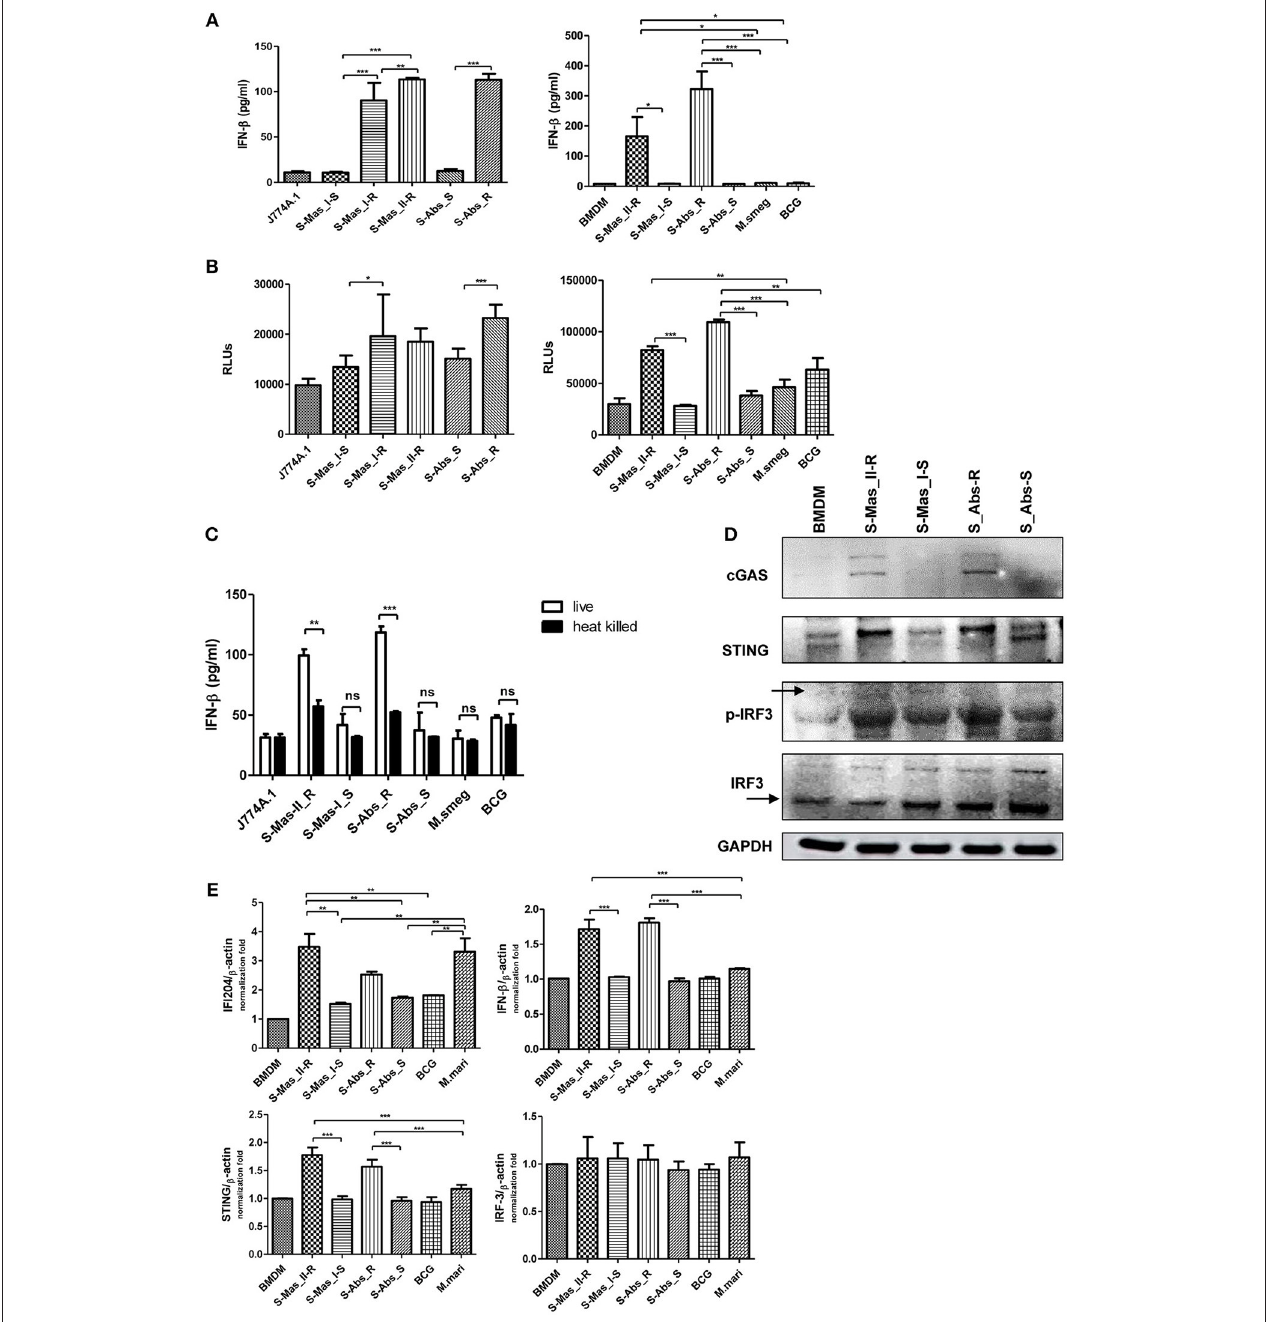
FIGURE 4 | Live MAB-R strains induce Type I IFN secretion via the cGAS-STING-IRF3 axis. (A,B) Supernatants were harvested 24h.p.i., and their Type I IFN levels were analyzed by IFN- β ELISA (A) and L929-ISRE luciferase bioassay (B) (32). The luciferase bioassay units are relative light units (RLUs). (C) J774A.1 cells were either uninfected (control) or infected with live or heat-killed (HK) bacteria, the supernatants of the infected cells were collected, and Type I IFN levels measured by IFN- β ELISA. (D) Western blot of IRF3, p-IRF3, cGAS, and STING induced by MAB-R [S-Abs_R ( M. abscessus type strain ATCC 19977 rough strain)] and MAB-S strains [S-Abs_S ( M. abscessus type strain ATCC 19977 smooth strain) and S-Mas_I-S (Asan 51843)], M. smegmatis , and BCG infection (10M.O.I.) of BMDMs for 24h. (E) qRT-PCR was used to measure the expression levels of IFI204, IFN- β , STING, and IRF3 mRNA in the BMDMs infected with rough strains [S-Abs_R ( M. abscessus type strain ATCC 19977 rough strain)] and S-Mas_II-R (Asan 50594)] and smooth strains [S-Abs_S ( M. abscessus type strain ATCC 19977 smooth strain) and S-Mas_I-S (Asan 51843)], M. bovis BCG, or M. marinum (10M.O.I.). The expression levels represent relative fold changes based on the β -actin level. The results are representative of two independent experiments and represent means ± SD . P -values were determined by one-way ANOVA with Tukey’s multiple comparison test (A,B,E) and paired Student’s t -test (C) using GraphPad prism program: ns, non-significant; * P < 0.05; ** P < 0.01, and *** P < 0.001.